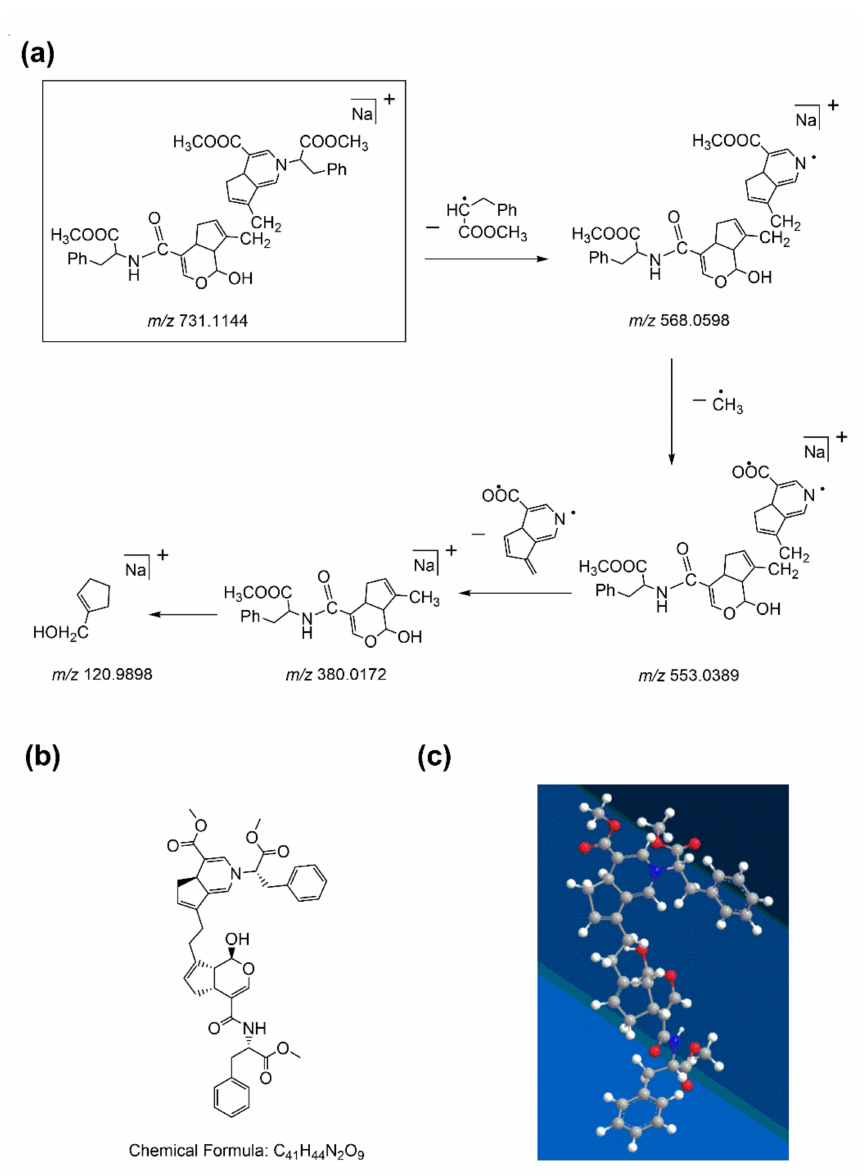
Figure 8. The fragmentation pathway of water-insoluble gardenia blue pigment Z-3 ( a ). The planar and 3D molecular structure simulation graphs of the pigment Z-3 ( b ) and ( c ) (C-gray, O-red, N-blue,